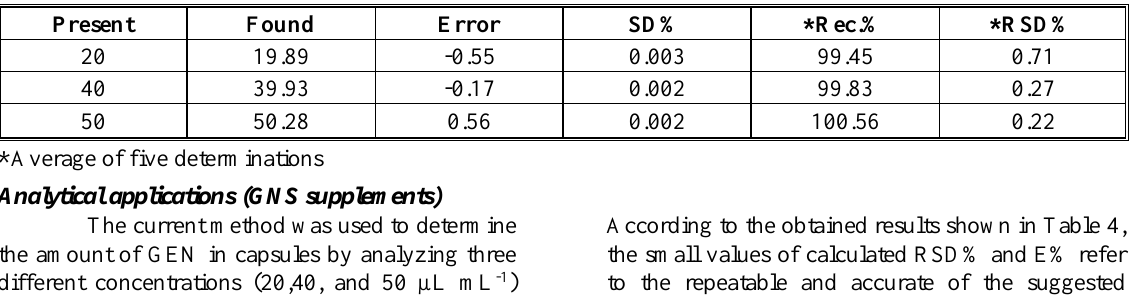
Table 4. Application of the proposed method for determining GEN in pharmaceutical formulations by using direct method Conc. GNS Alternative Medicine